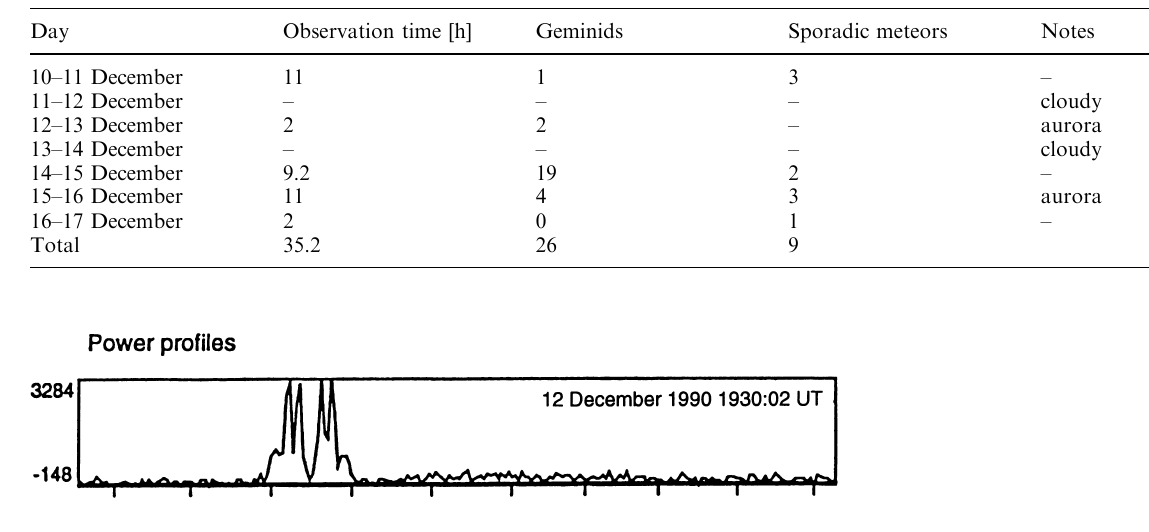
Table 2. Optical meteors observed at